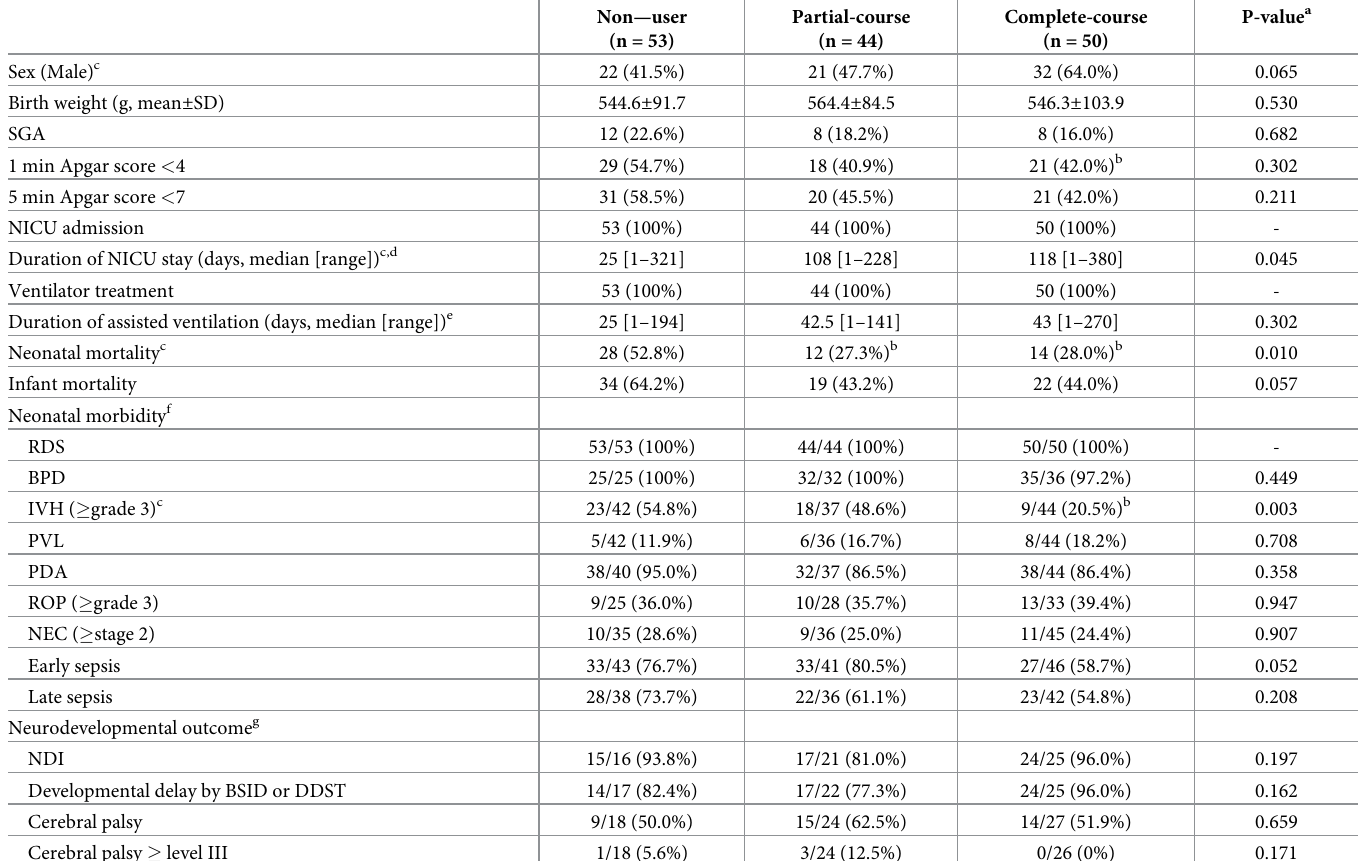
Table 4. Neonatal outcome according to exposure to antenatal corticosteroid